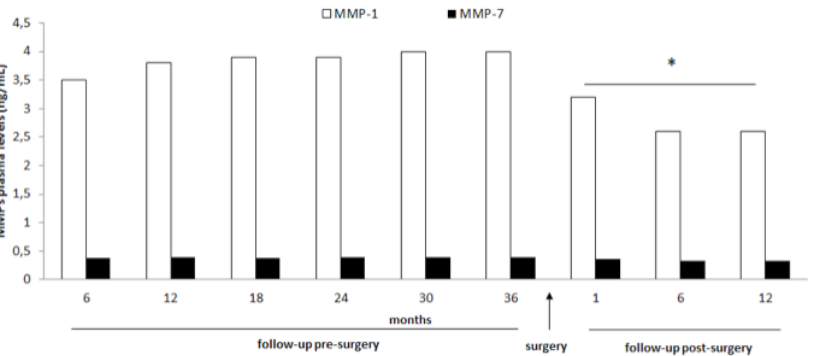
Figure1: Plasma levels of MMP-1 and MMP-7, measured through ELISA test in patients during the follow-up before and after the surgery. *P<0.01 post-surgery vs pre-surgery.